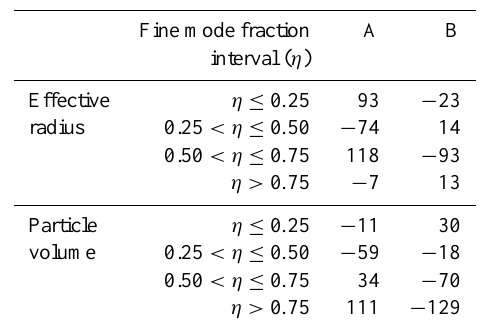
Table 1. Correction functions computed by fitting LE retrievals to those of the operational AERONET code. We perform linear fits (cid:49)r eff = Aη + B for the effective radius and (cid:49)V = Aη + B for par- ticle